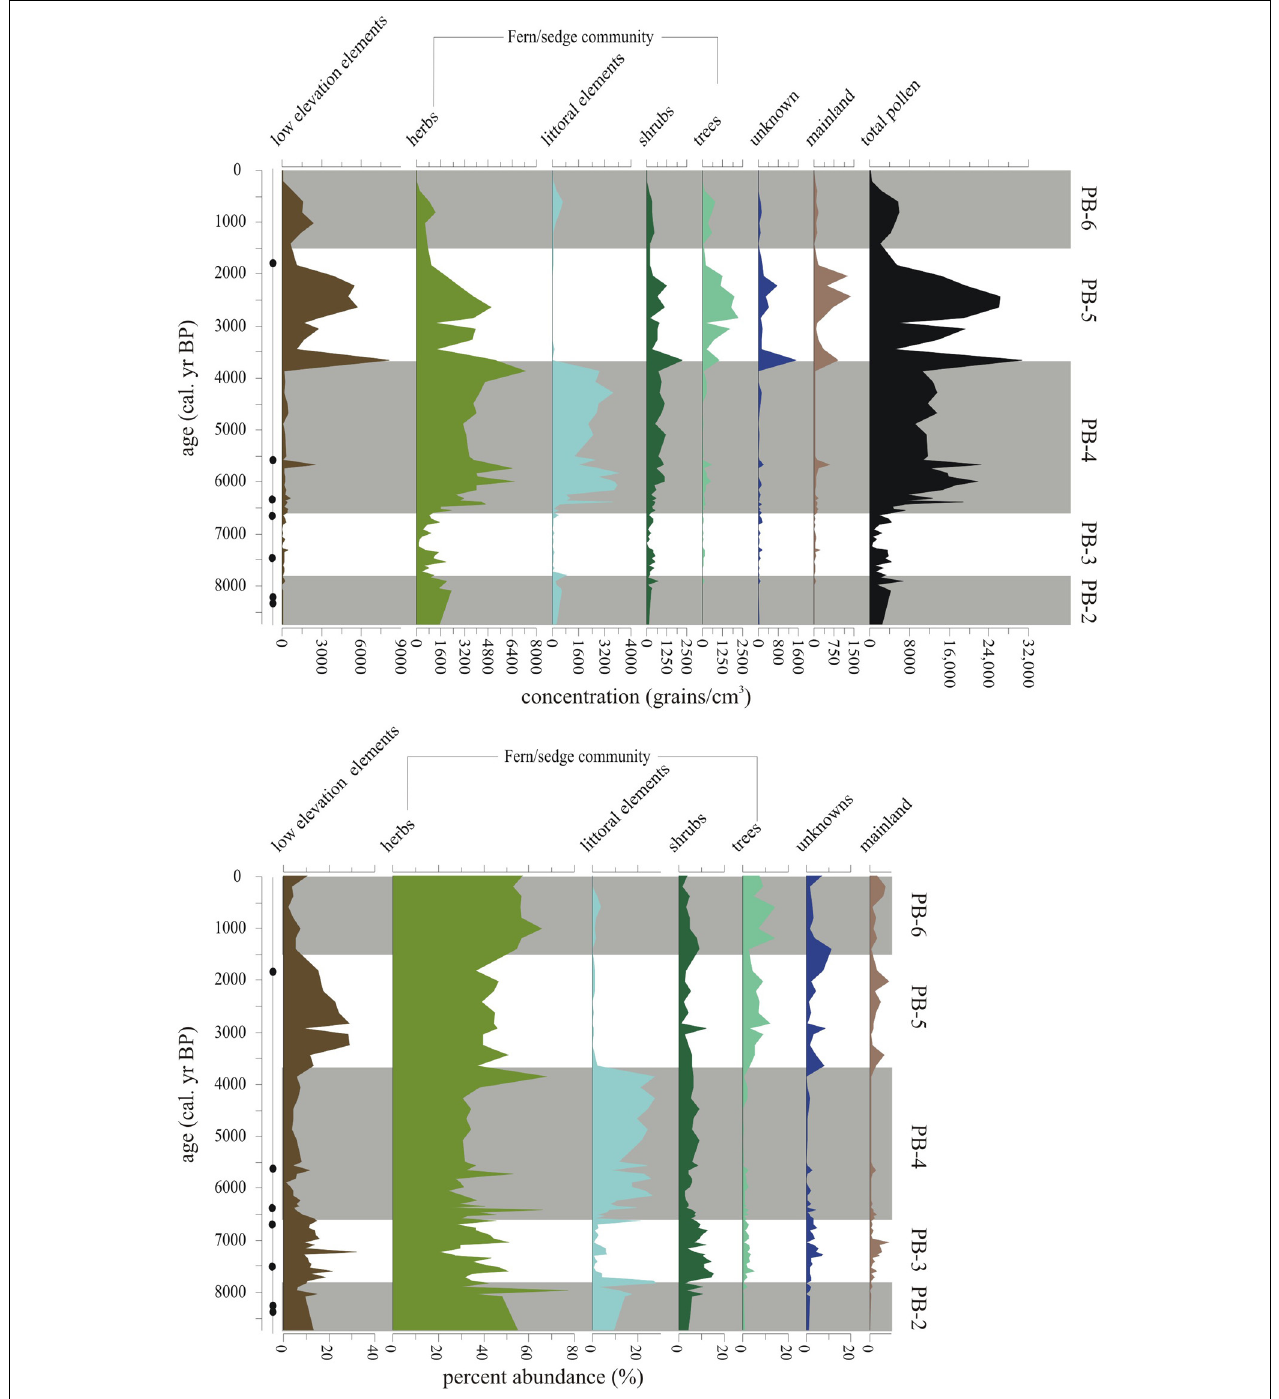
FIGURE 8 | Summary diagram of the concentrations (grains/cm 3 ) and percent abundance (%) of Holocene-aged vegetation types represented in Paul’s Bog. Local pollen zones are shown. Radiocarbon date locations (solid circles) on right of age axis.